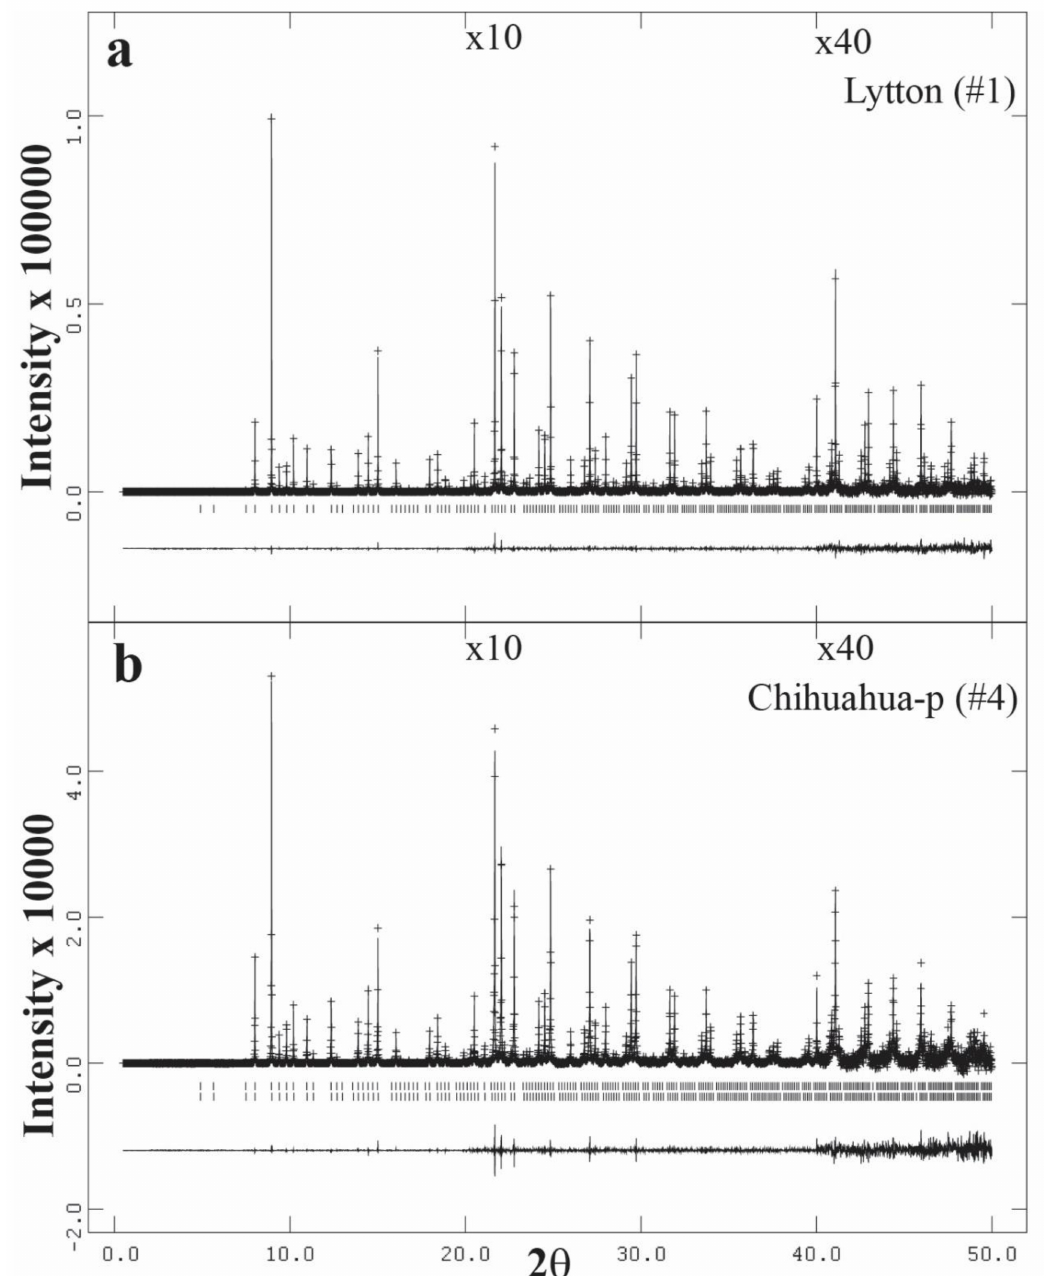
Figure 11. Complete HRPXRD traces for ( a ) sample-1 from Lytton, Canada, and ( b ) sample-4 from Chihuahua-p, Mexico. Data for sample-4 were modelled using two slightly different cubic phases, whereas sample-1 was modelled with a single cubic phase. The difference curve ( I obs − I calc ) is shown at the bottom. Short vertical lines indicate allowed reflection positions. The intensities and difference curves that are above 20 ◦ and 40 ◦ 2 θ are multiplied by 10 and 40, respectively. Similar features are displayed in other traces shown. To avoid repetition, these descriptions will not be